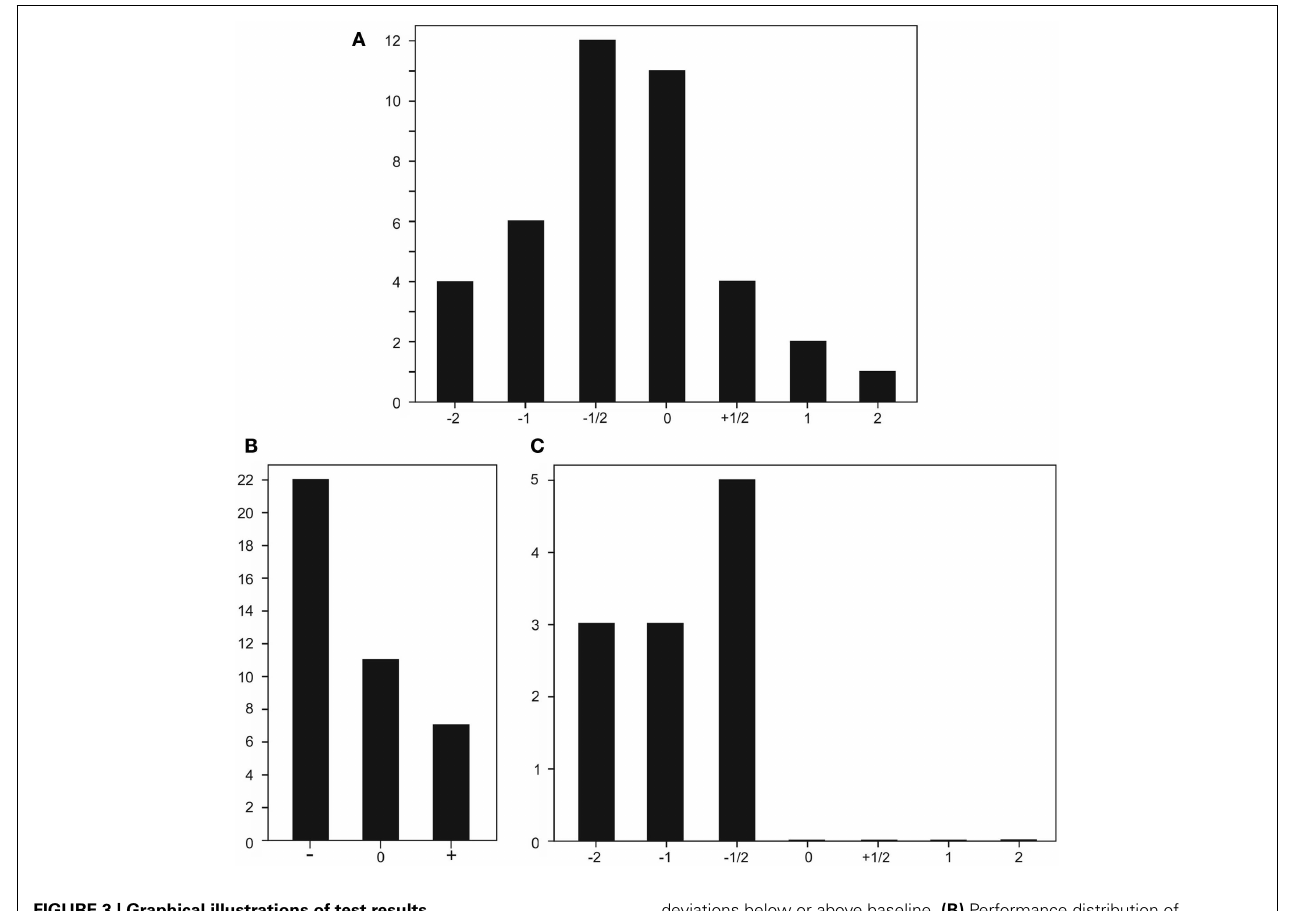
FIGURE 3 | Graphical illustrations of test results . (A) Performance distribution in all 40 tests applied; scores roughly refer to standard deviations: 1/2 = less than a standard deviation below ( − ) or above ( + ) 0; ± 1 or ± 2 refer to about 1 or 2 standard